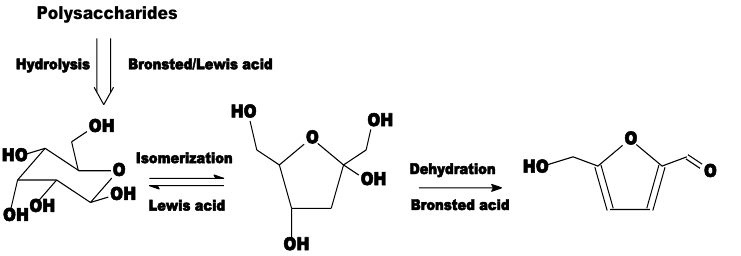
Figure 9. Hydrolysis of polysaccharides and cascade reactions of glucose as a platform chemical to HMF transformation over SO 3 H-MIL-101(Cr) material.